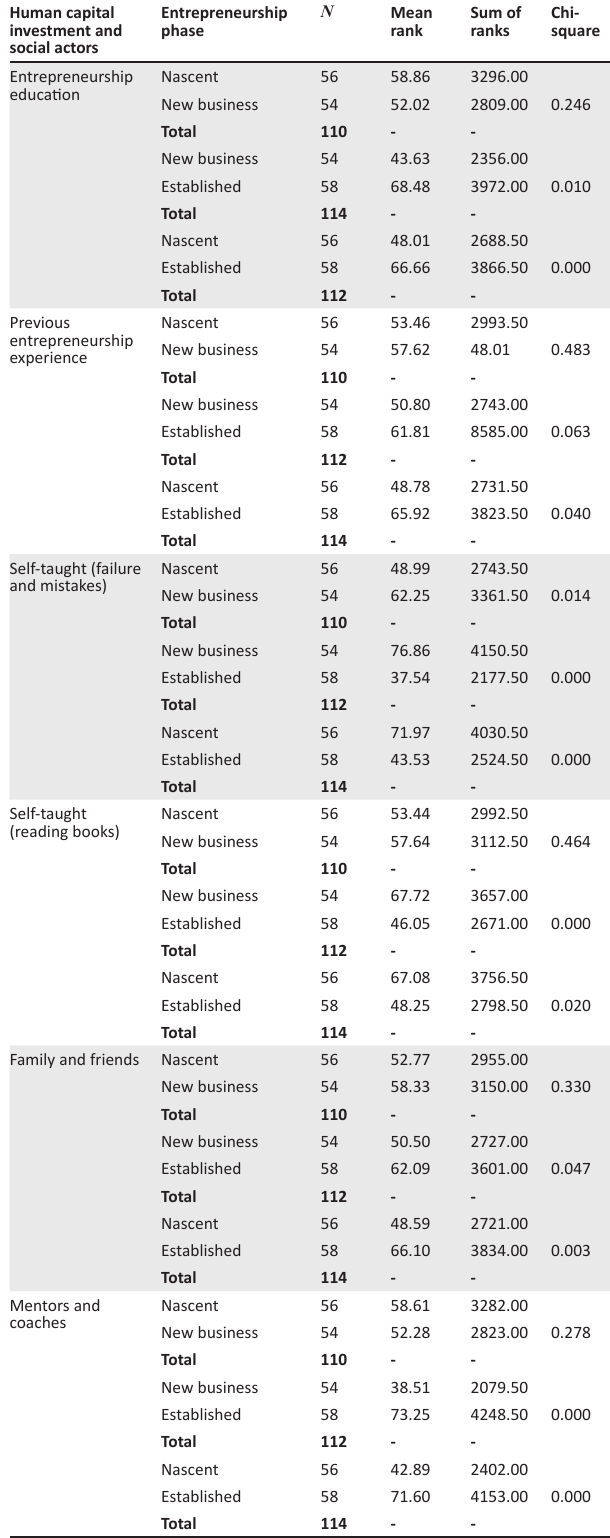
TABLE 1: Kruskal–Wallis test for human capital investments and social actors. TABLE 2: Mann–Whitney U test for human capital investments and social